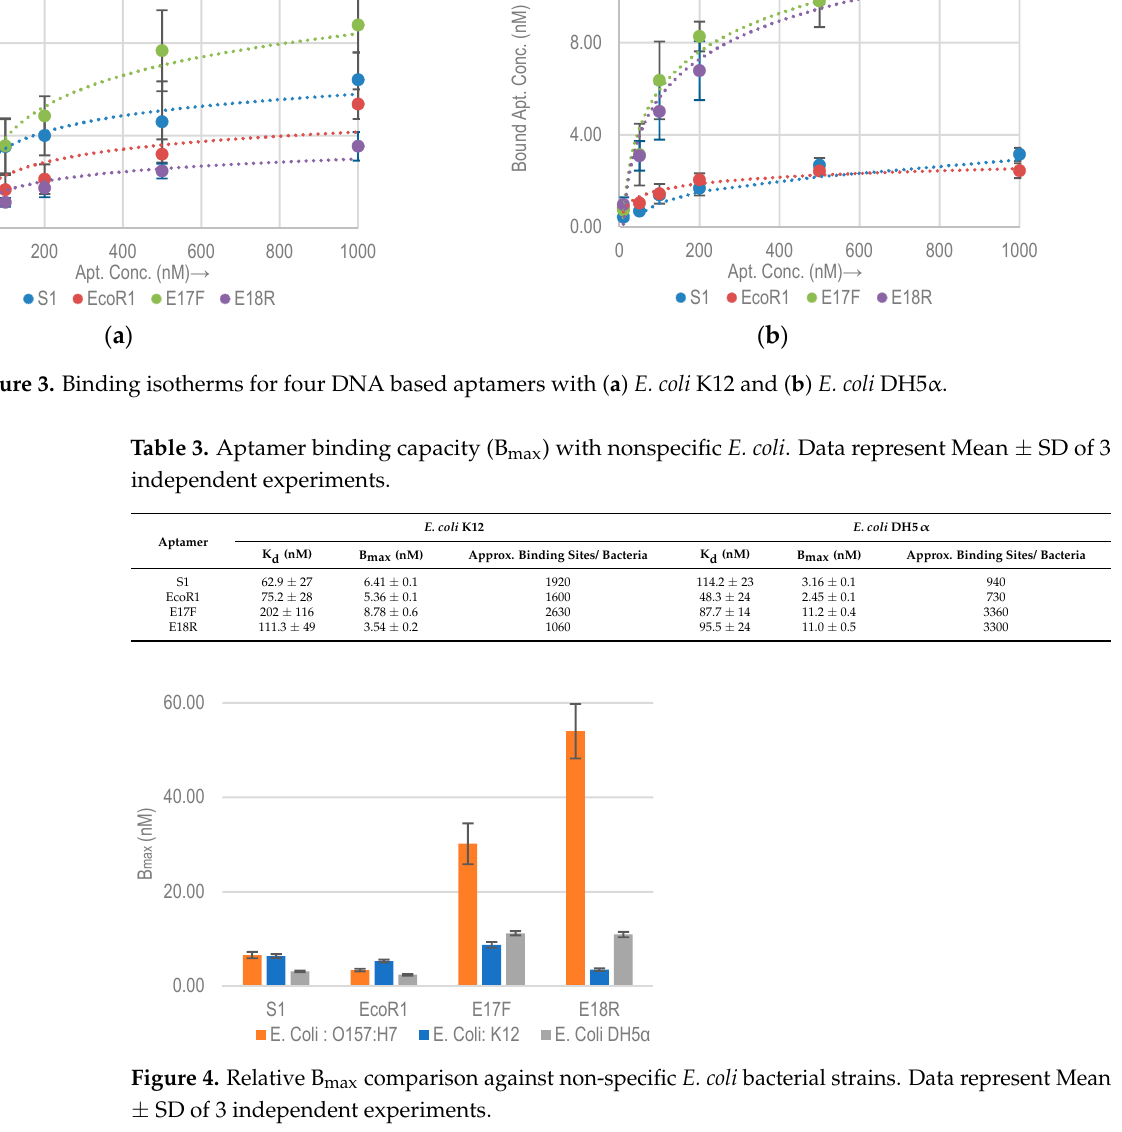
Figure 4. Relative B max comparison against non-specific E. coli bacterial strains. Data represent Mean ± SD of 3 independent experiments.